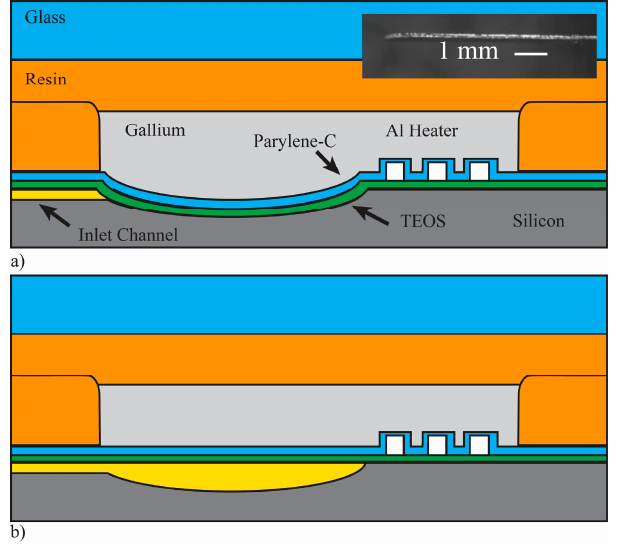
Figure 3. Gallium-based phase change actuator in the solidified (closed) state ( a ); and liquified (open) state ( b ). Inset : micro-ingot of Ga used for length-based resolution of sub-mg quantities.